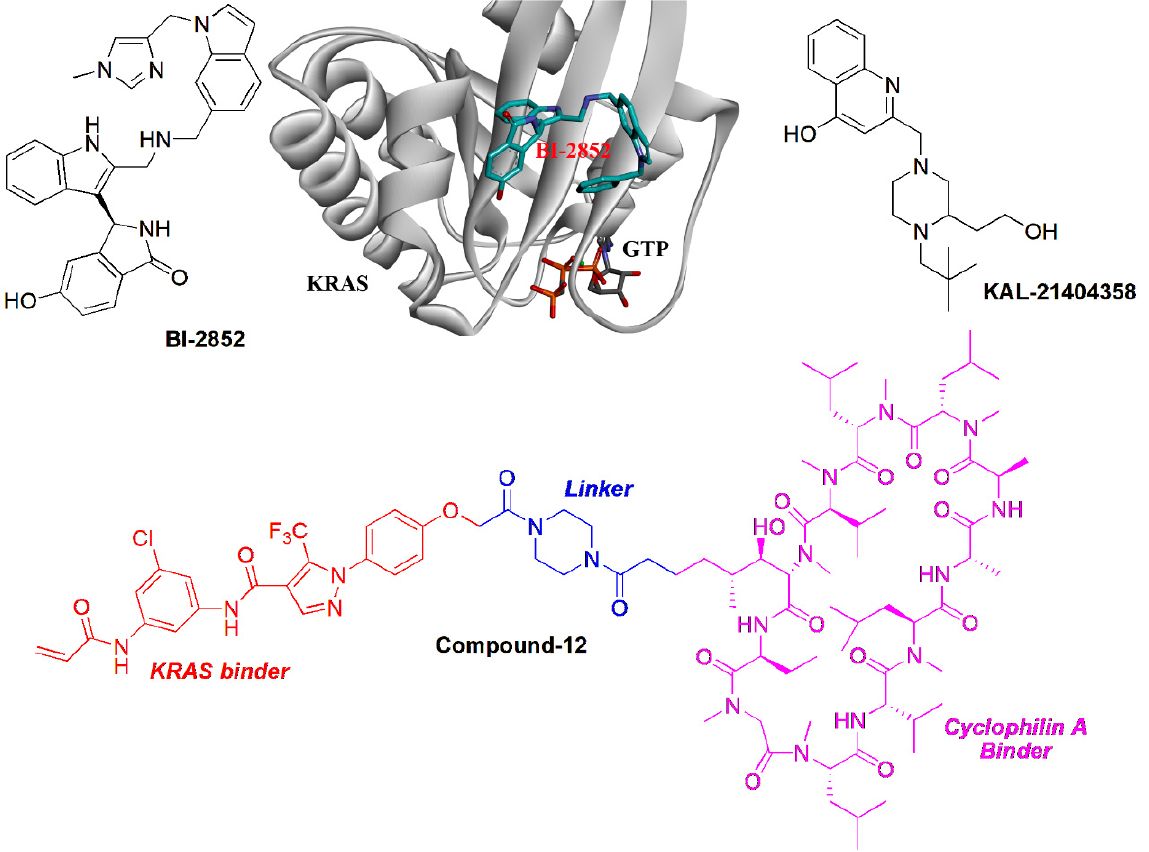
Figure 5. The targeting protein and protein interaction strategies for KRAS inhibitors.